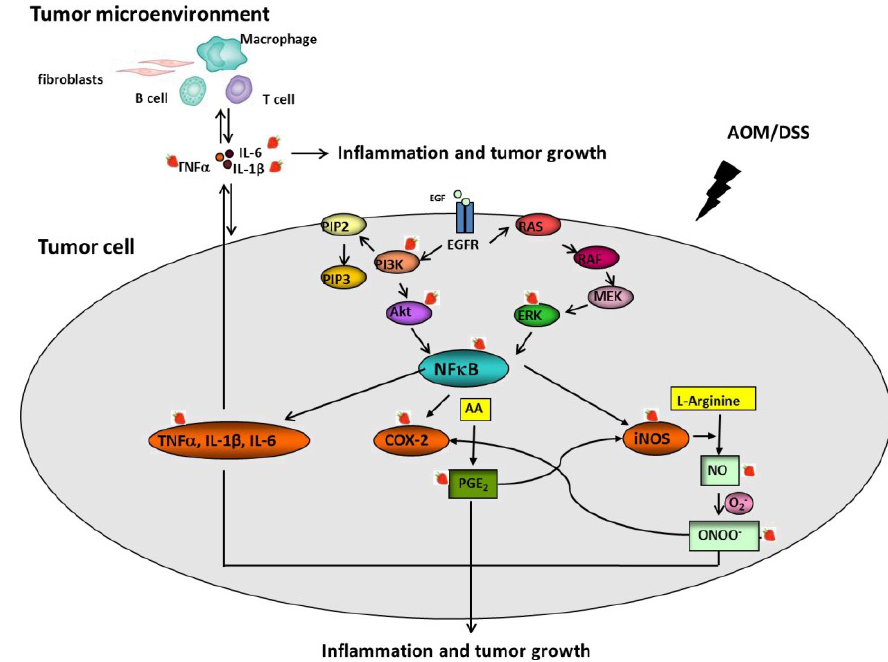
Figure 4. Possible interactive mechanisms of inhibition of AOM/DSS-induced colon cancer in mice by